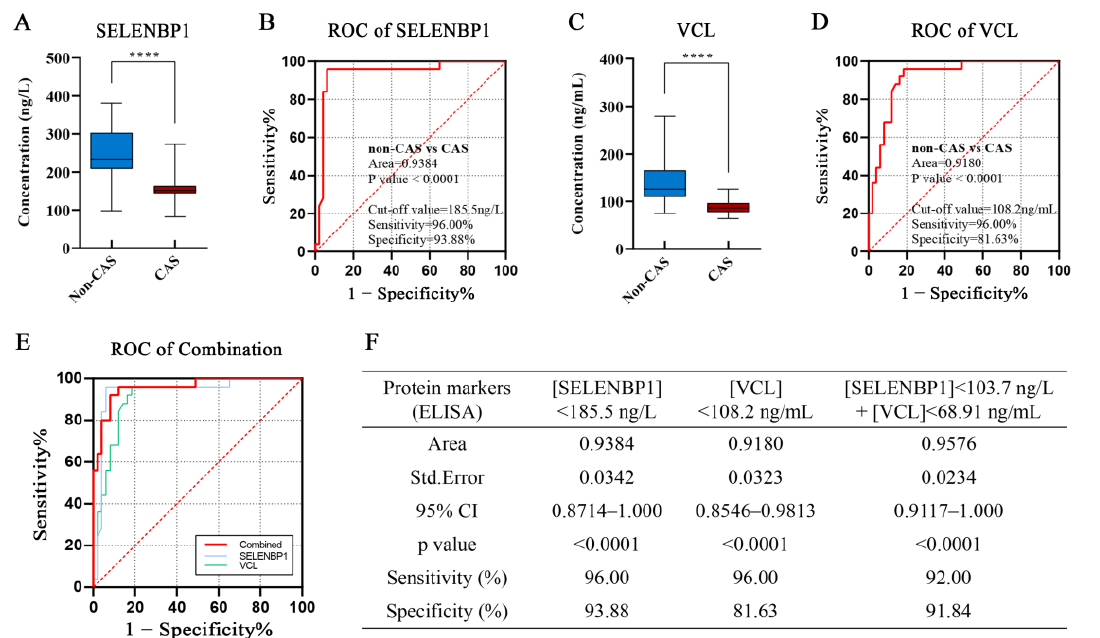
Figure 5. Serum SELENBP1 and VCL were effective biomarkers for clinical diagnosis of CAS. ( A ) Serum levels of SELENBP1 in non-CAS and CAS patients. ( B ) Receiver operating characteristics (ROC) analysis of serum SELENBP1 for diagnosis of CAS. ( C ) Serum levels of VCL in non-CAS and CAS patients. ( D ) ROC analysis of serum VCL for diagnosis of CAS. ( E ) ROC analysis of the combination of serum SELENBP1 and VCL for diagnosis of CAS. ( F ) A summary of the diagnostic efficacy in clinic for SELENBP1 and VCL alone or in combination. ****, p < 0.0001 as indicated. CI—confidence interval; Std. Error—standard error.